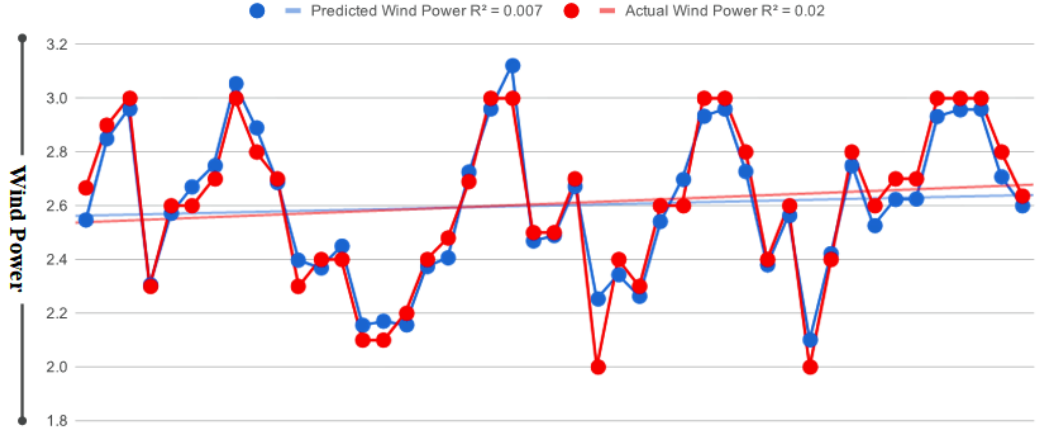
Figure 6. Forecasted and Actual Power (kW) outcomes for Windfarm 2 via the Proposed Methodology.